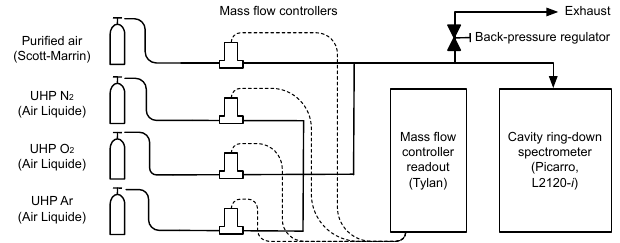
Figure 1. Schematic diagram of the mixing system used for the experiments. Pure background gases were obtained commercially, mixed with mass flow controllers and supplied to the inlet of the L2120- i at a slight overpressure. See text for